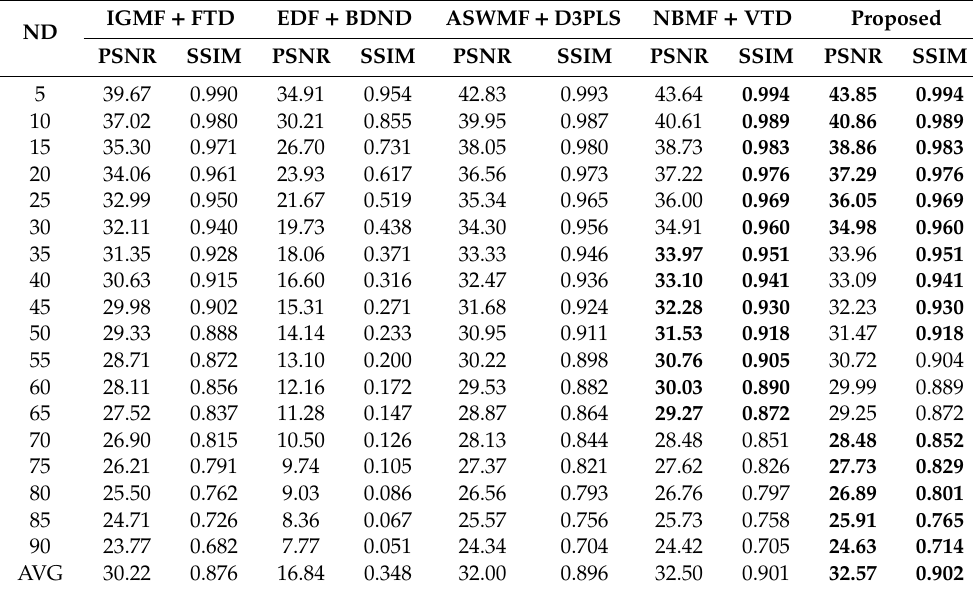
Table 5. The results of the state-of-art